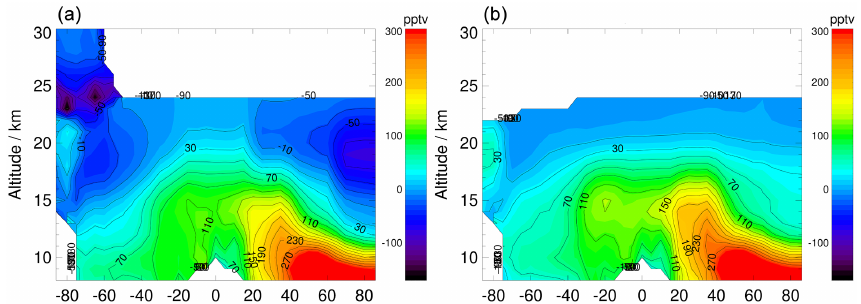
Figure 3. PAN altitude–latitude cross sections (July 2008) from a separate retrieval using the old CCl 4 distributions (a) and resulting from a joint retrieval with CCl 4 (b)